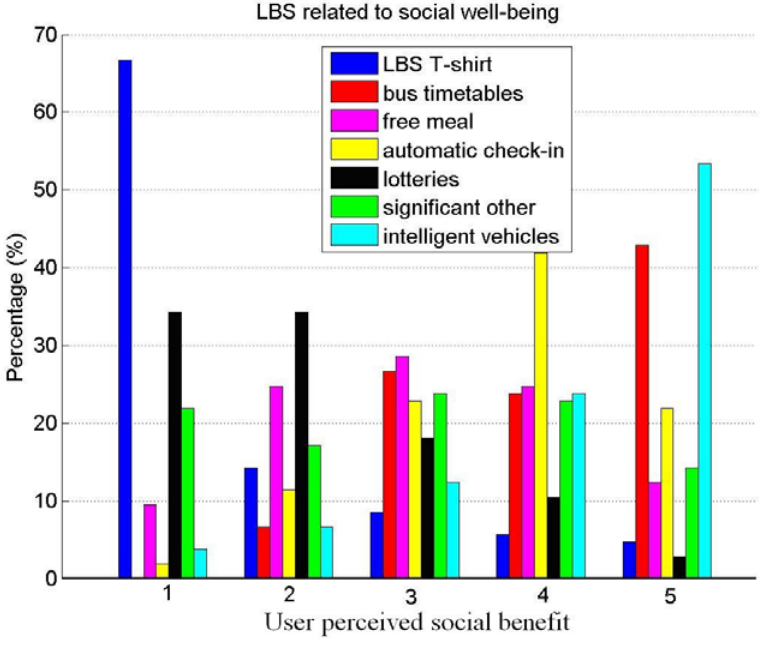
Figure 19. Histogram of users’ views regarding the potential increase of social wellbeing through various